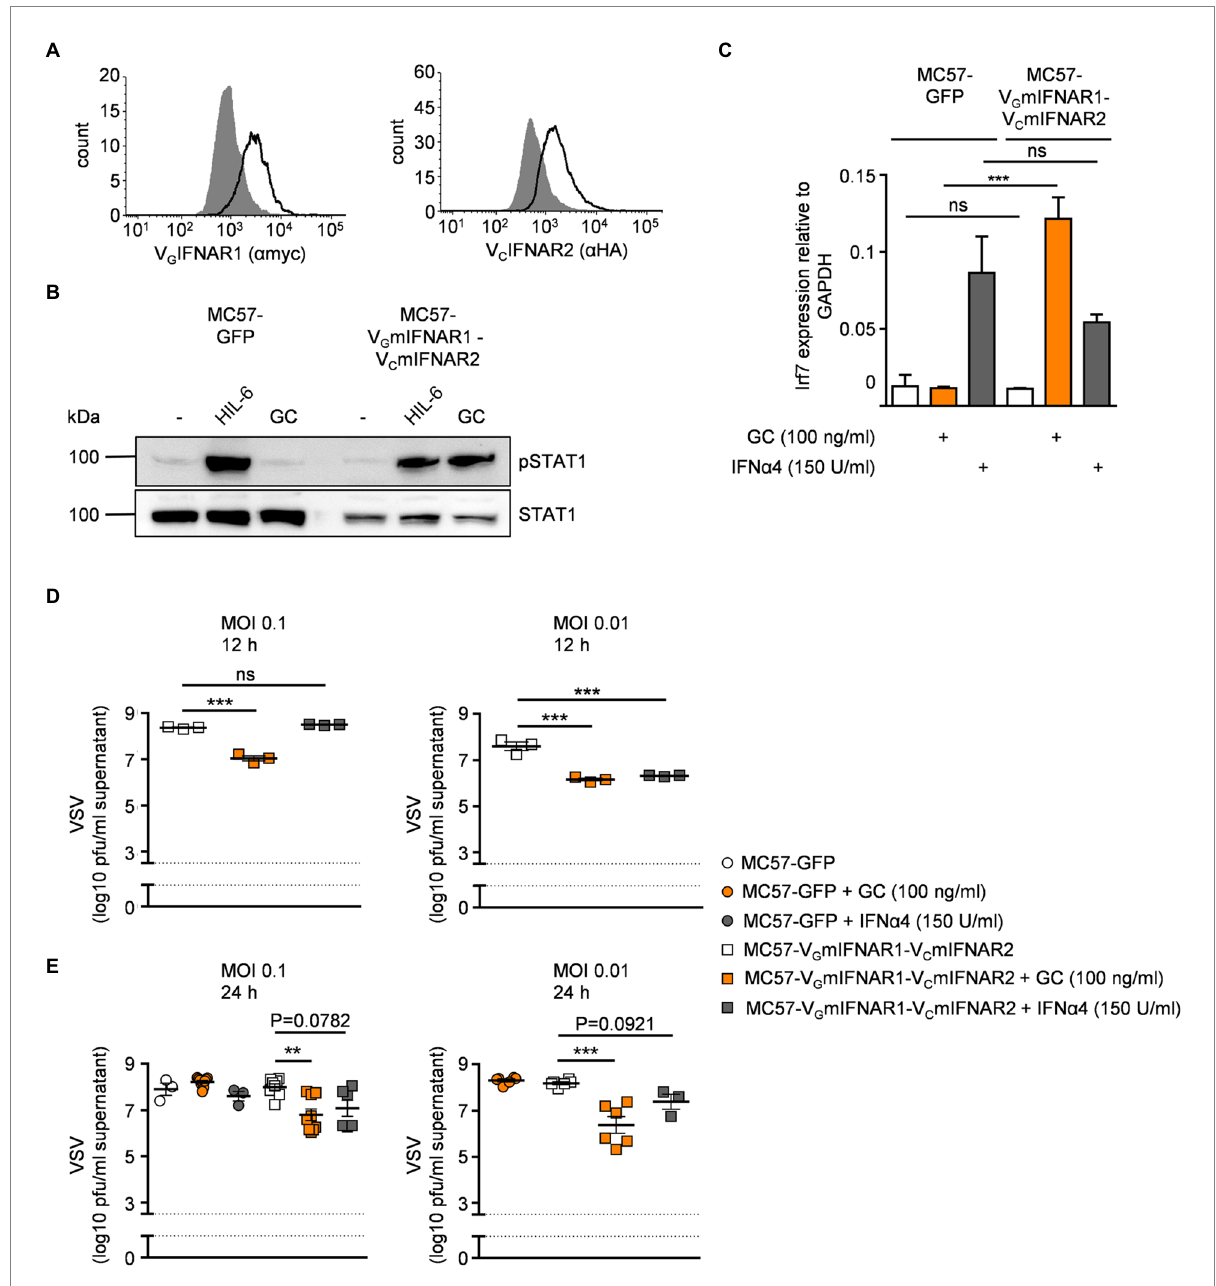
FIGURE 5 Synthetic IFNARs have antiviral activity in MC57 cells. (A) Cell surface expression of MC57 cells transduced with murine V G IFNAR1 and V C IFNAR2. Expression was demonstrated via antibodies detecting myc-tagged IFNAR1 (left panel) or HA-tagged IFNAR2 (right panel) and is indicated as solid line. Gray-shade areas indicate non transduced MC57 cells (negative control). (B) STAT1 activation in MC57 cells stably expressing murine V G IFNAR1 and V C IFNAR2 treated with 10 ng/ml Hyper-IL-6 or 100 ng/ml of the synthetic cytokine ligand GC for 30 min. Equal amounts of proteins (50 μ g/lane) were analyzed via specific antibodies detecting phospho-STAT1, STAT1. Western blot data shows one representative experiment out of three. (C) Quantification of mRNA expression of Irf7 for IFN α 4 (150 U/ml) or GC (100 ng/ml) stimulation of MC57-GFP and MC57-V G mIFNAR1- Vm C IFNAR2 cells. One representative experiment out of three is shown. (D) MC57-V G mIFNAR1-Vm C IFNAR2 cells were treated with medium, IFN α 4 (150 U/ml) or synthetic GC ligand (100 ng/ml), followed by infection with VSV (multiplicity of infection [MOI]). Viral titers in the supernatants were measured 12 h after infection. (E) MC57-GFP and MC57-V G mIFNAR1-Vm C IFNAR2 cells were treated with medium, IFN α 4 (150 U/ml) or synthetic GC ligand (100 ng/ml), followed by infection with VSV (multiplicity of infection [MOI]). Viral titers in the supernatants were measured 24 h after infection. ** p ≤ 0.01; *** p ≤